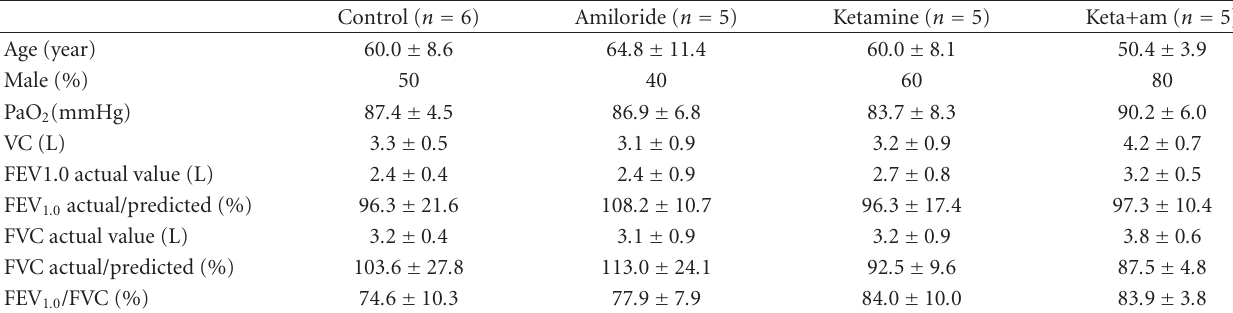
Table 1: Clinical characteristics of patients.